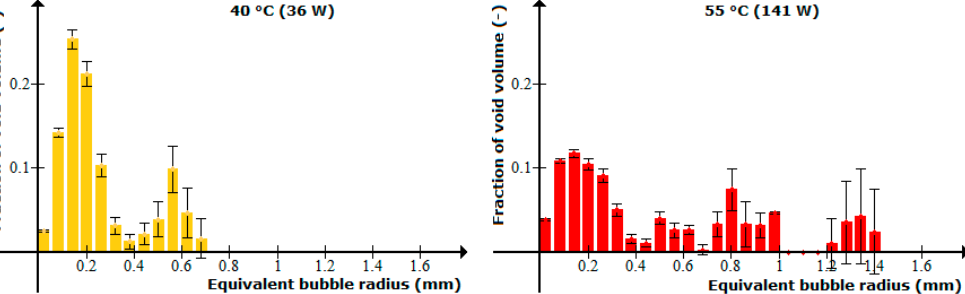
Figure 10. Bubble size distributions for two extreme cases (lowest and highest heating power) at low refrigerant mass flux (150 kg/m 2 s).